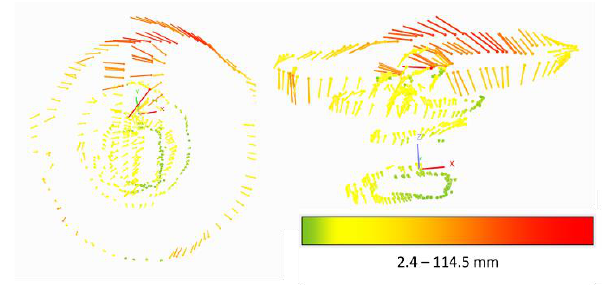
Figure 7. Changes in exterior orientation translation parameters als difference vectors from B to B+F96 for data sets 4+5 (graphic from AICON 3D